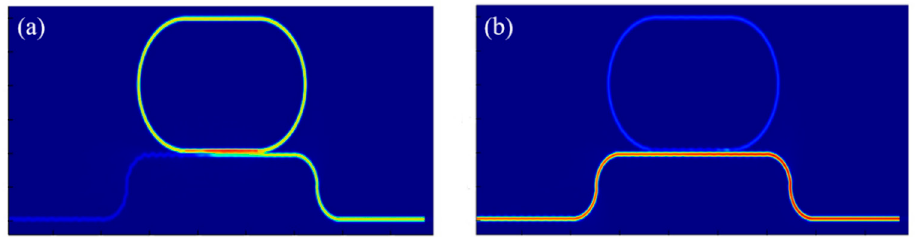
Figure 8. Optical power distribution of the designed switch simulated by the 3D-FDTD method at resonance wavelength near 1547.4 nm in ( a ) a-GSST (OFF) and ( b ) c-GSST (ON) states.